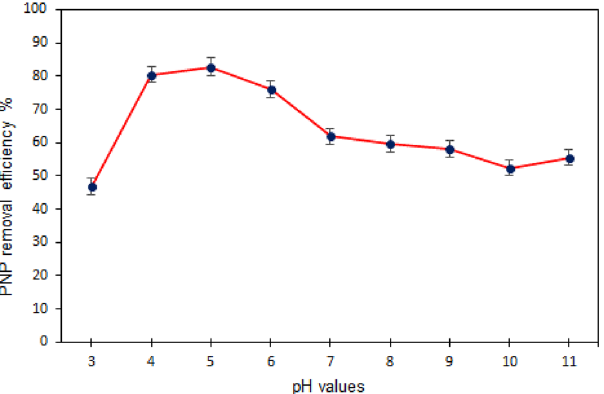
Figure 8. Effect of the solution’s pH on PNP adsorption by TMA-(PA6- g -GMA) at different pH values (50 mg/L initial concentration of PNP, 0.1 g/100 mL adsorbent dosage, temperature 298 K, time 1-h and 150 rpm).